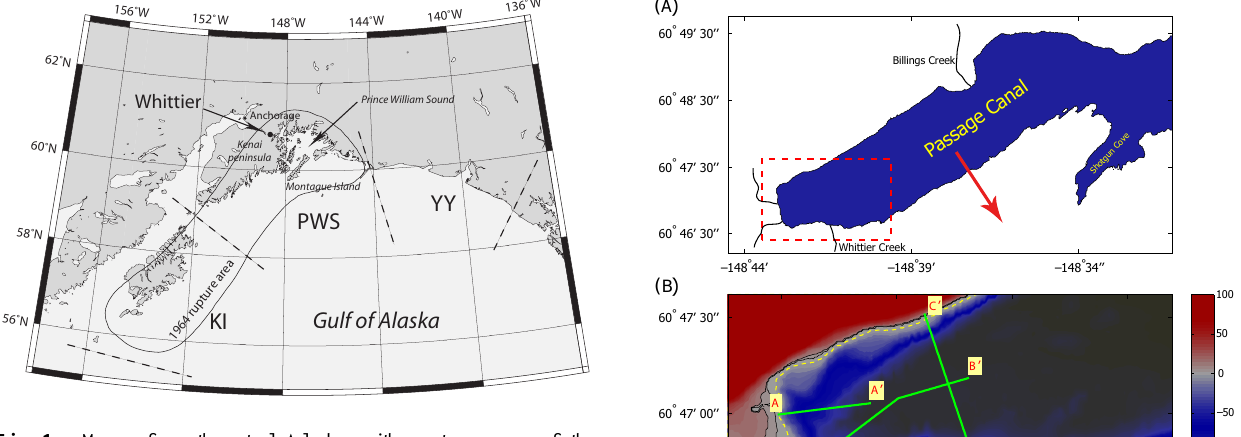
Fig. 1. Map of southcentral Alaska with rupture zone of the 1964 Great Alaska Earthquake and segments of the Alaska-Aleutian megathrust: the Prince William Sound (PWS), Kodiak Island (KI) and Yakataga-Yakutat (YY) segments.